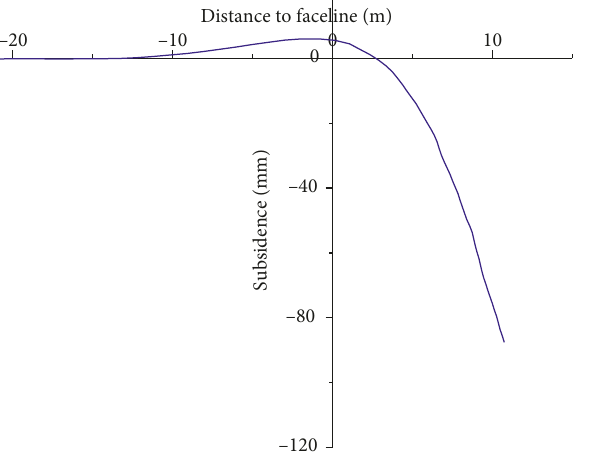
Figure 6: Subsidence of the voussoir beam structure above the rib side.